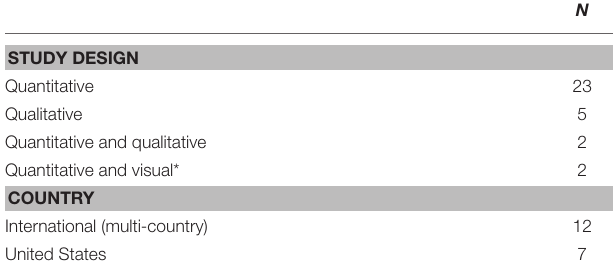
TABLE 1 | Characteristics of the included studies.